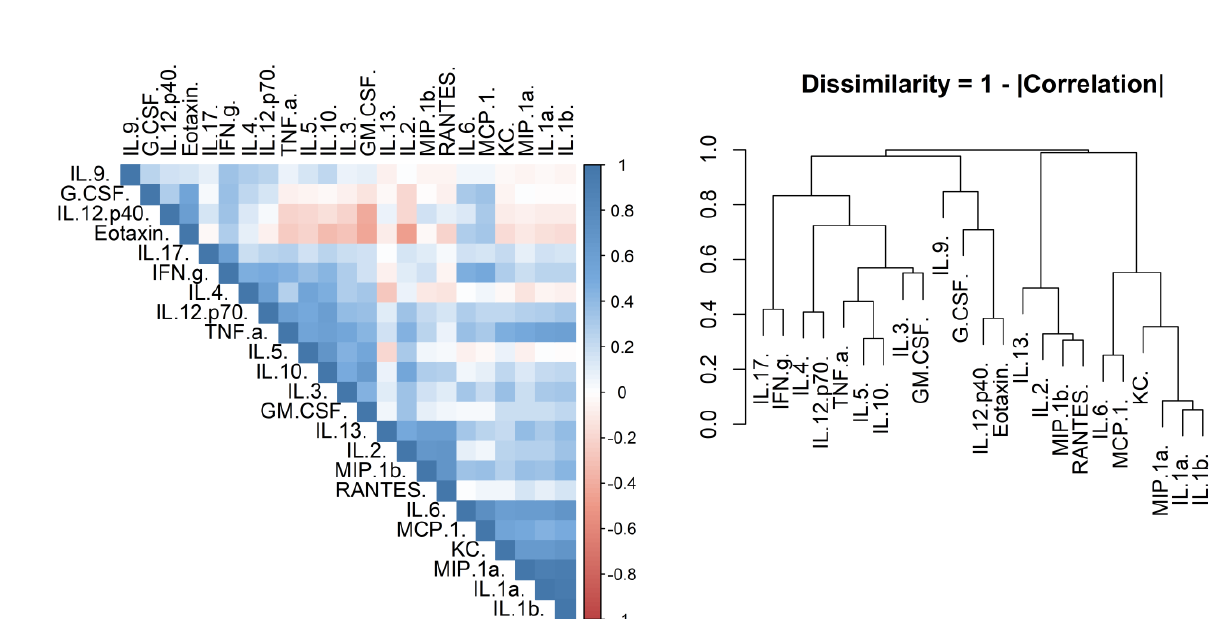
Figure 6. The relationship of cytokine concentration in animals treated with antibiotics. Correlation matrices detailing the relationship between the concentrations of different cytokine in different organs. Mice were infected with a mean retained dose of 142 CFU of B. pseudomallei by the inhalational route and treated with finafloxacin (37.5 mg/kg) every 8 h or co-trimoxazole (78 mg/kg) every 12 h, orally, for 14 days, initiated at 24 h post-challenge. The data was from both treatment groups combined. The order of the metric was derived based on cluster analysis. The colour density associated with each cell is the Pearson’s correlation mapped to the colour-scale left of the matrix. This data is also shown as dendrogram for dissimilarity (1 minus Pearson’s r divided by 2). In this way, the analytes have been clustered by similarity. This data was split by plasma, spleen, lung and expressed collectively.